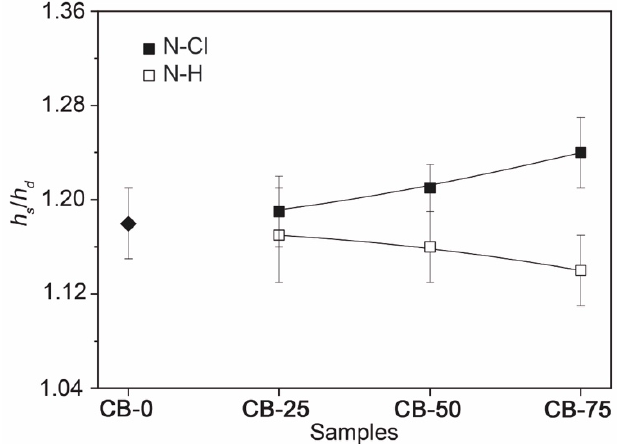
Figure 4. Swelling ratio h s / h d of CB-0 , CB-25 , CB-50 , and CB-75 .